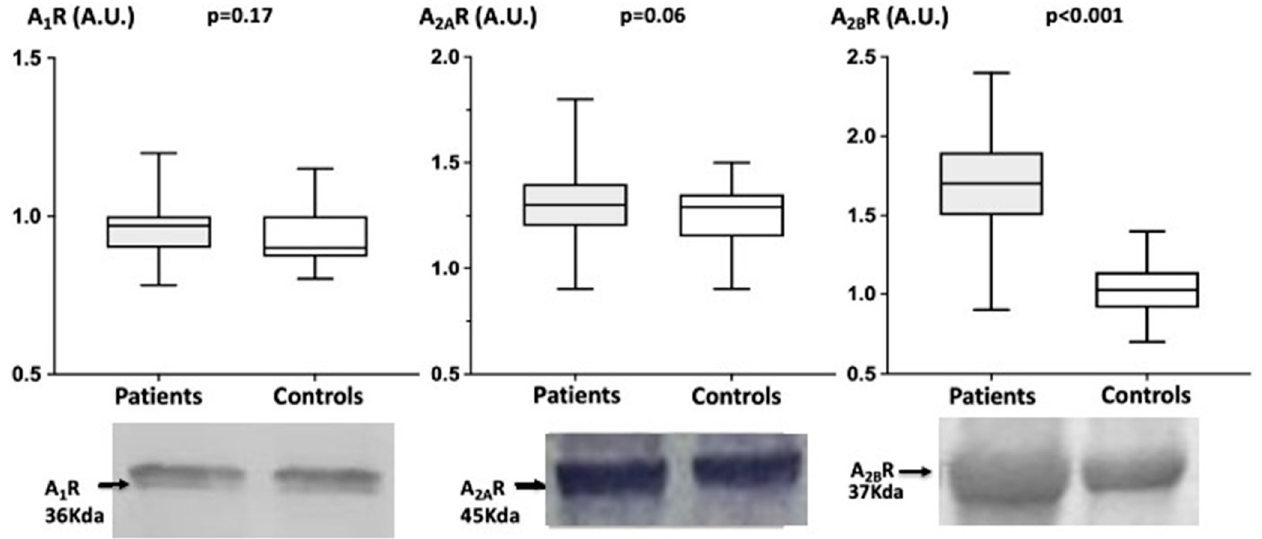
Figure 2. Comparison (median and range) of adenosine receptors production in PBMCs in patients with fibromuscular dysplasia ( n = 67) and healthy subjects ( n = 40). Original blots are given in supplement file.